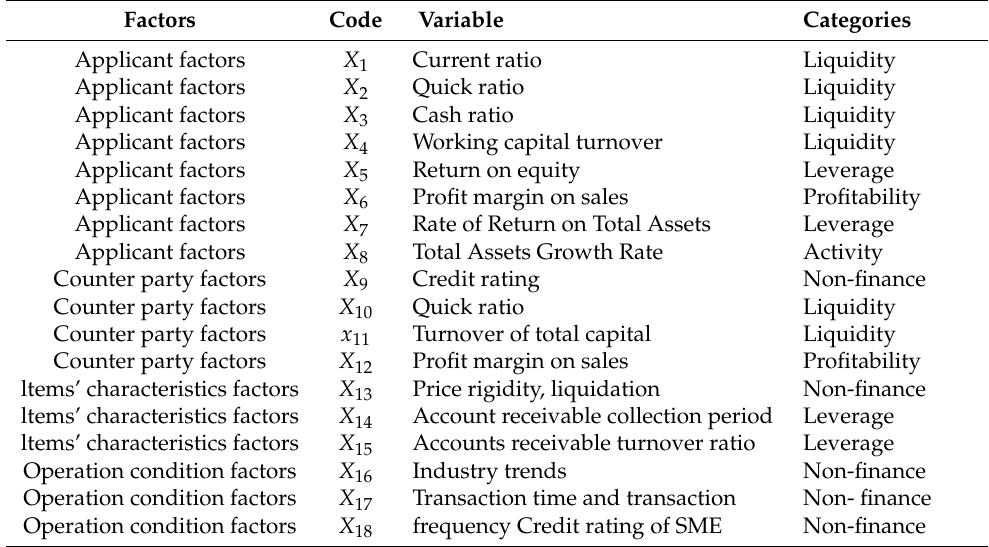
Table 2. Credit-risk factors and the classification of listed